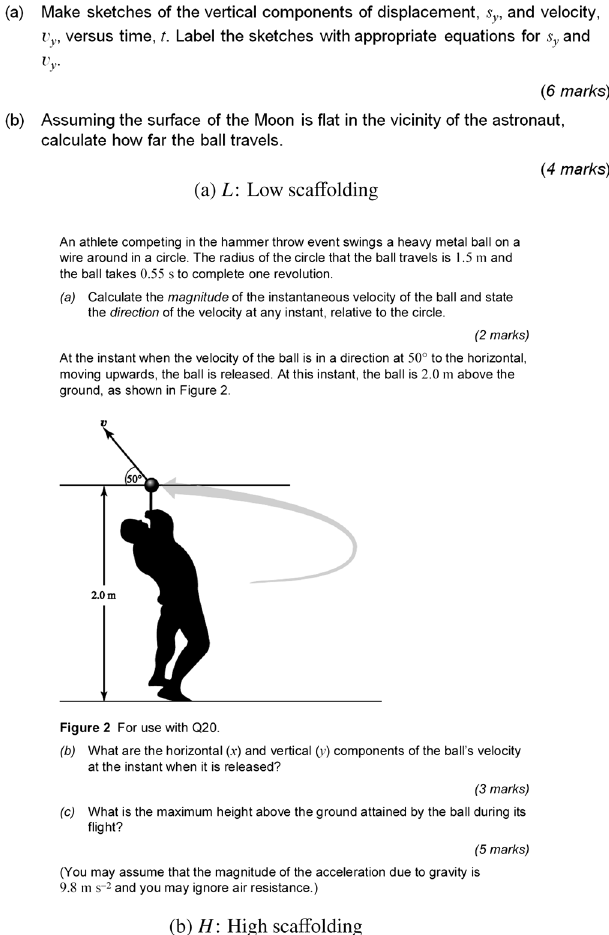
FIG. 4. A pair of two-dimensional projectile motion problems of different scaffolding levels. Male students very significantly outperform female students on L , but performance is equal across gender on H